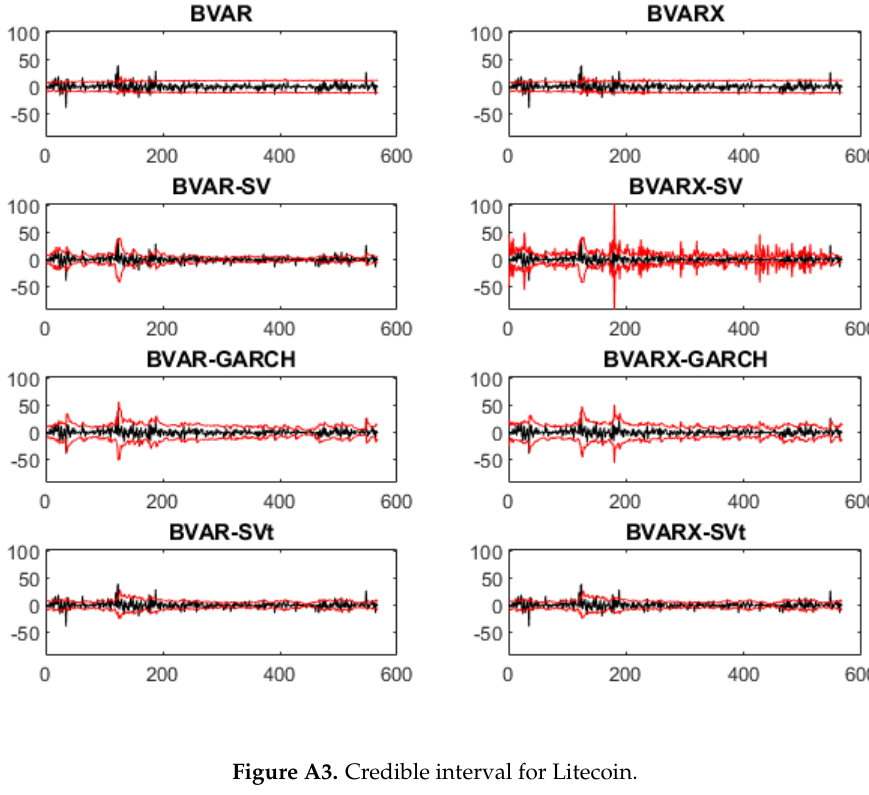
Figure A3. Credible interval for Litecoin.